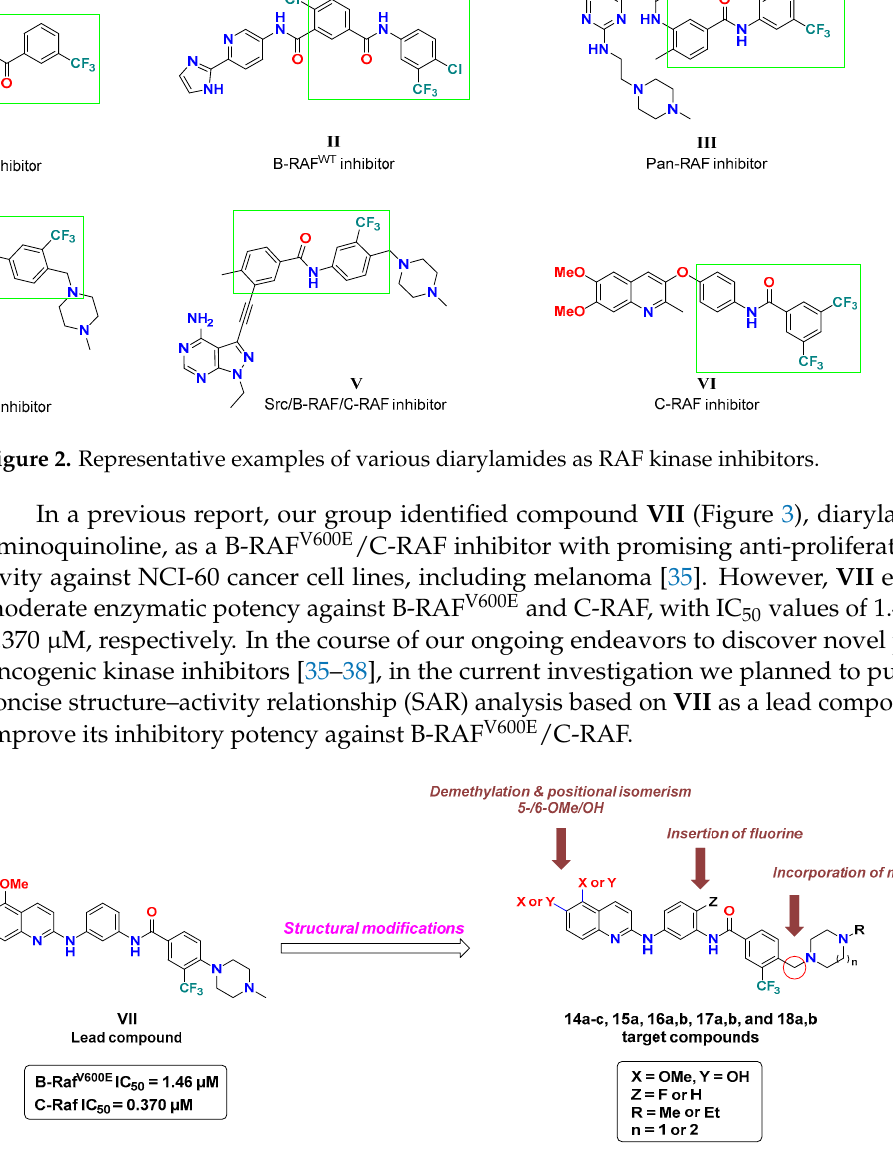
Figure 3. Structural modifications of lead compound VII for the discovery of novel RAF kinase inhibitors.